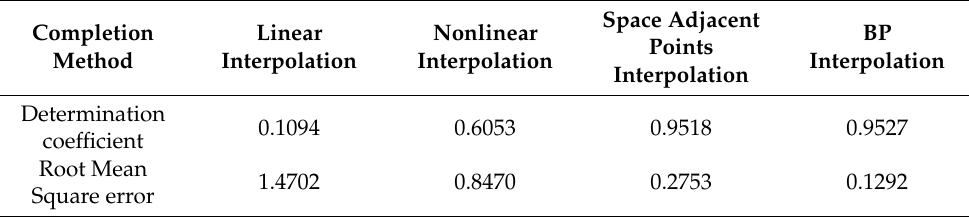
Figure 8. Comparison diagram of missing value completion results. Table 4. Comparison of completion accuracy of missing values.